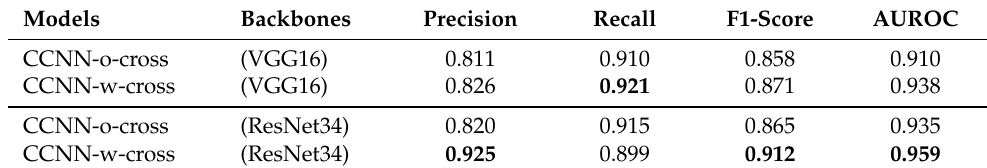
Table 4. Ablation study of with/without triple stream on single modality dataset